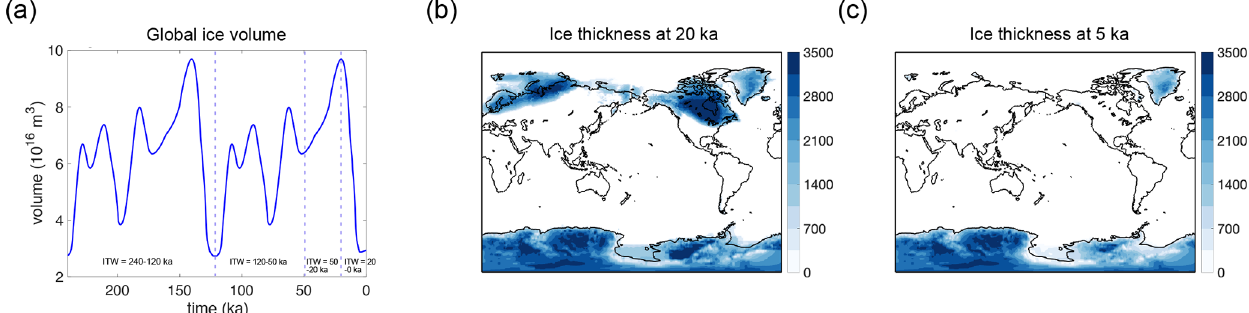
Figure 4. Changes in global ice-sheet volume and thickness and in the 240kyr simulation. (a) Global volume variations through the last 240kyr. Vertical dashed lines mark the internal time windows. (b, c) Snapshots of ice thickness at (b) 20ka and (c)